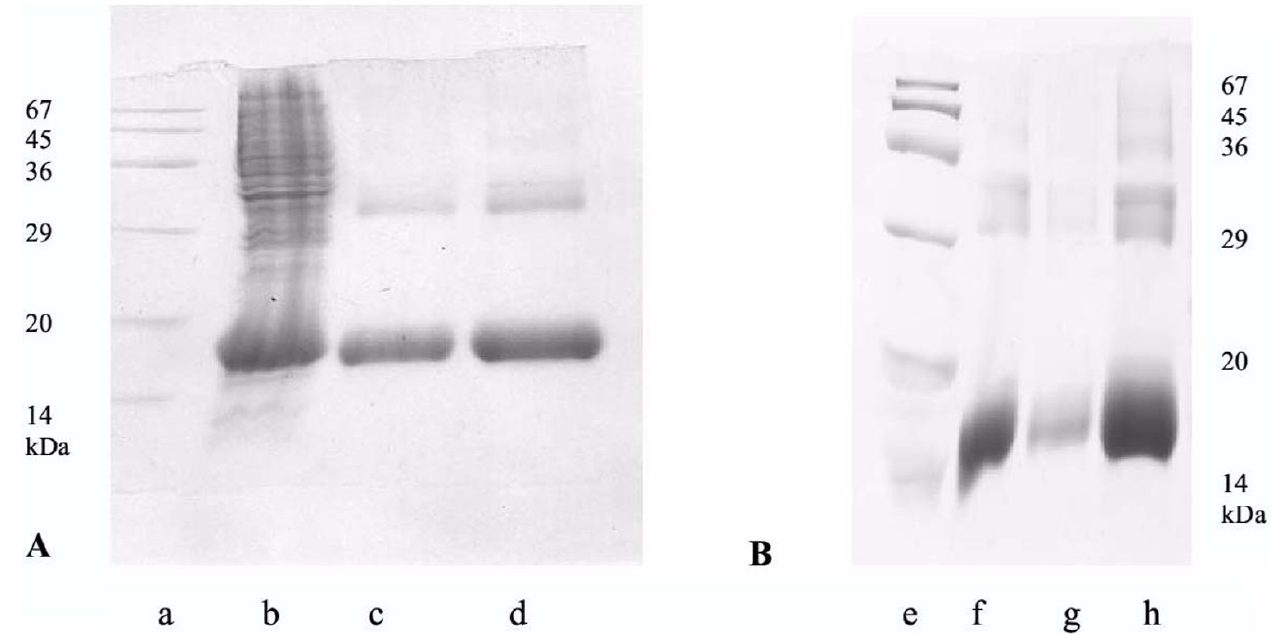
Figure 1 Electrophoresis of Galectin-1 Preparations SDS-PAGE analysis of 15% gels of recombinant human galectin-1 prepara- tions A a) marker proteins b) bacterial lysate containing M1R mutant galectin-1 c) M1R galectin-1, purified by affinity chroma-